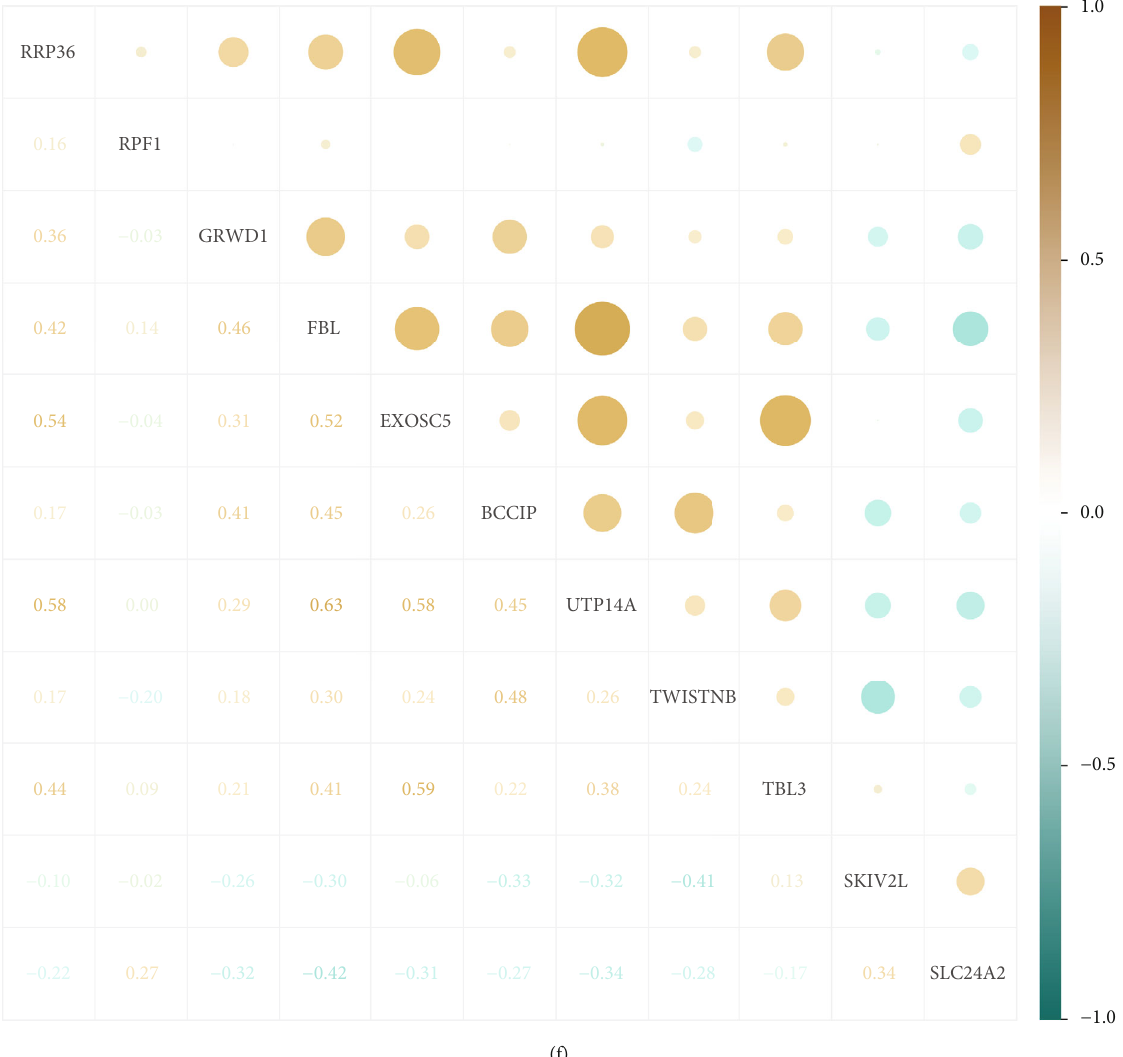
Figure 2: Weighted correlation network analysis. (a) Soft threshold selection. (b) Identi fi cation of 8 gene modules with WGCNA. (c) Correlation heat map of modules and phenotypes, red represents positively correlated with the phenotype, and green represents negatively correlated with the phenotype. (d) GO analysis of genes included in the grey module. (e) Protein-protein interaction of genes included in the grey module. (f) Correlation between SLC24A2 and its related 10 hub genes, green indicates negative correlation, and yellow indicates positive correlation. GO: Gene